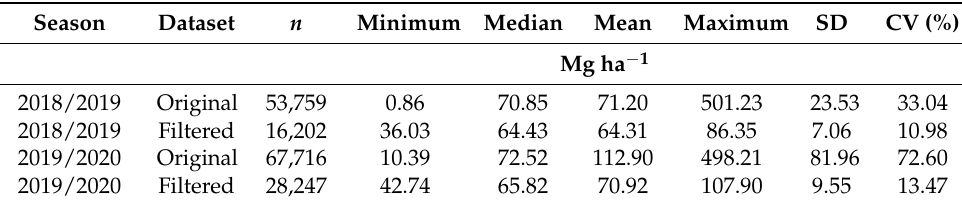
Table 4. Descriptive statistics of the sugarcane yield data considering all